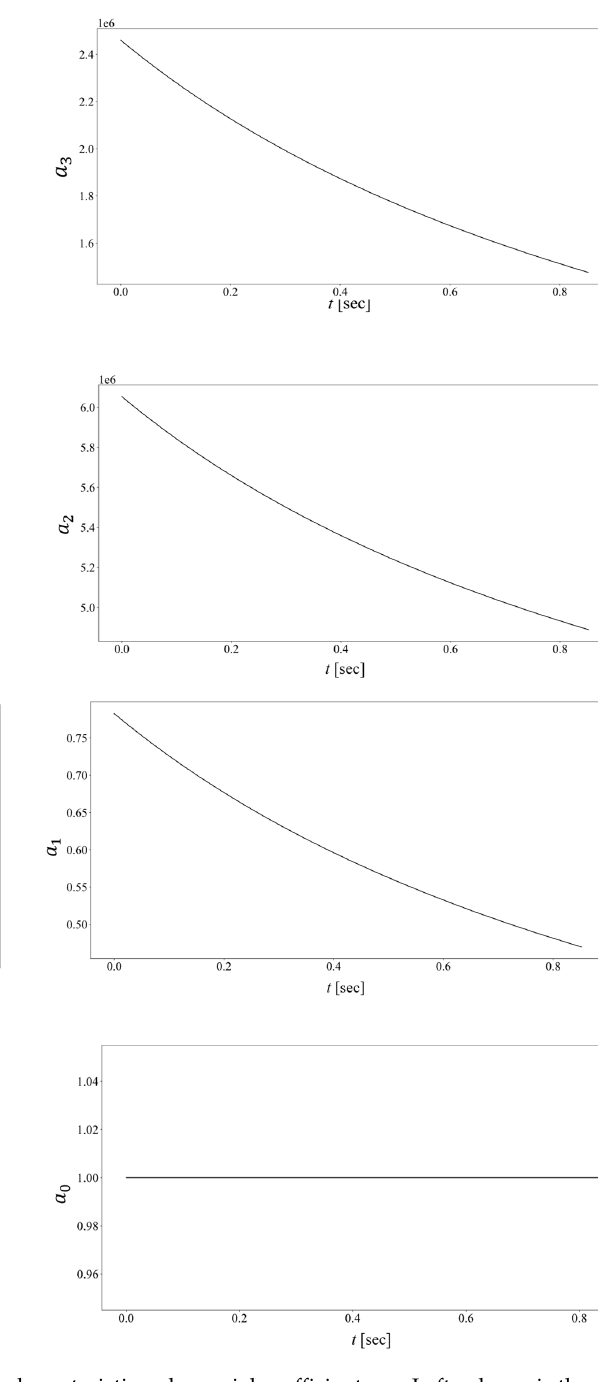
Figure 2. Time evolution of the characteristic polynomial coefficients 𝑎 (cid:3041) : Left column is the attached mass decrease from R = 0.20 to R = 0.02; right column is the attached mass increase from R = 0.02 mass decrease from 𝑅 = 0.20 to 𝑅 = 0.02 ; right column is the attached mass increase from 𝑅 = to R = 0.02 to 𝑅 = 0.20 .